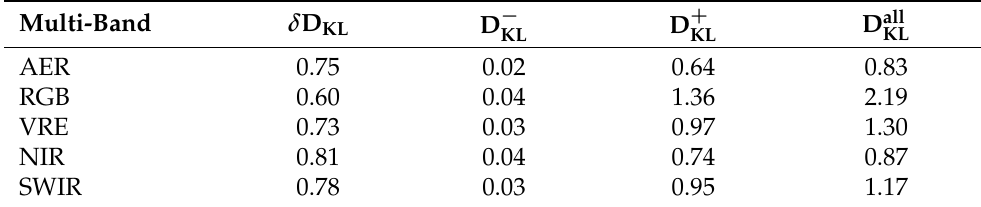
Figure 7. Comparison of the binary prediction for each channel group between the normal case and the different occlusion strategies. The normal (blue line) distribution is the same for each row, while the y-scale is different across columns in order to fit the other curves. Table 4. Divergences for the F 1 score distributions. The first column shows the difference between the up- and down-attention occlusion as in Equation (3). The other ones are the values are the D KL ( P stays for , + and all Q ∗ ) where || ∗ −